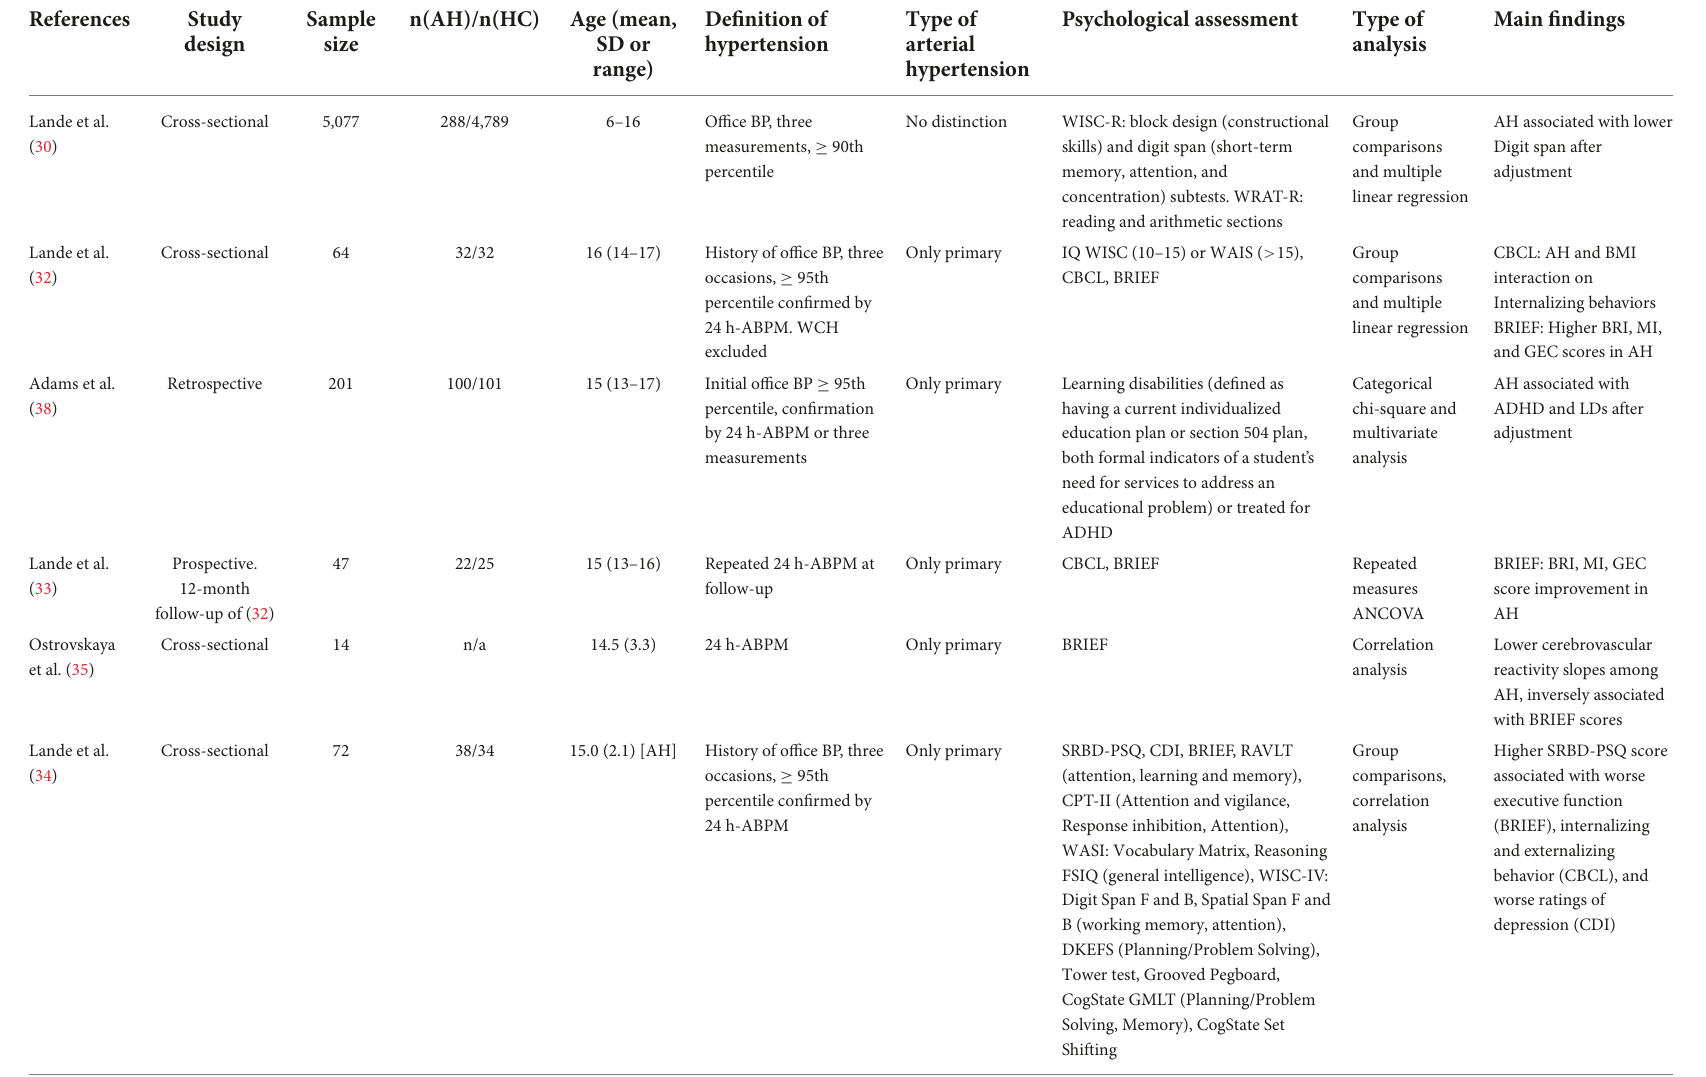
TABLE 1 Studies that evaluated cognitive impairment in children and adolescents with primary